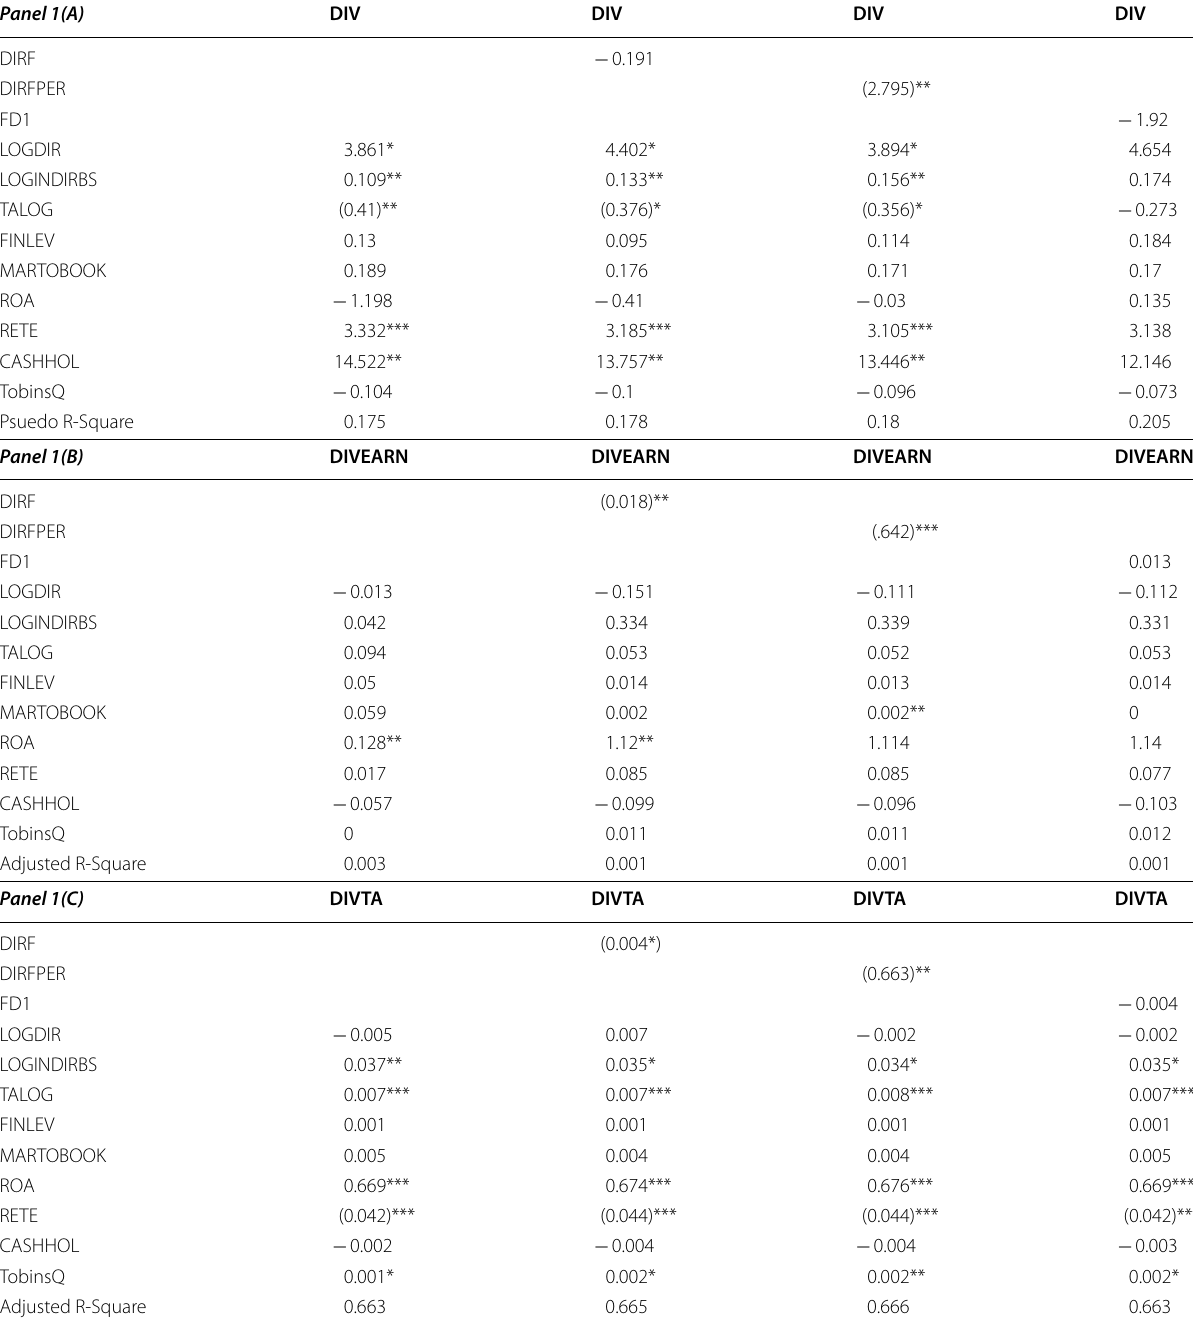
Table 4 Board gender diversity and dividend payout